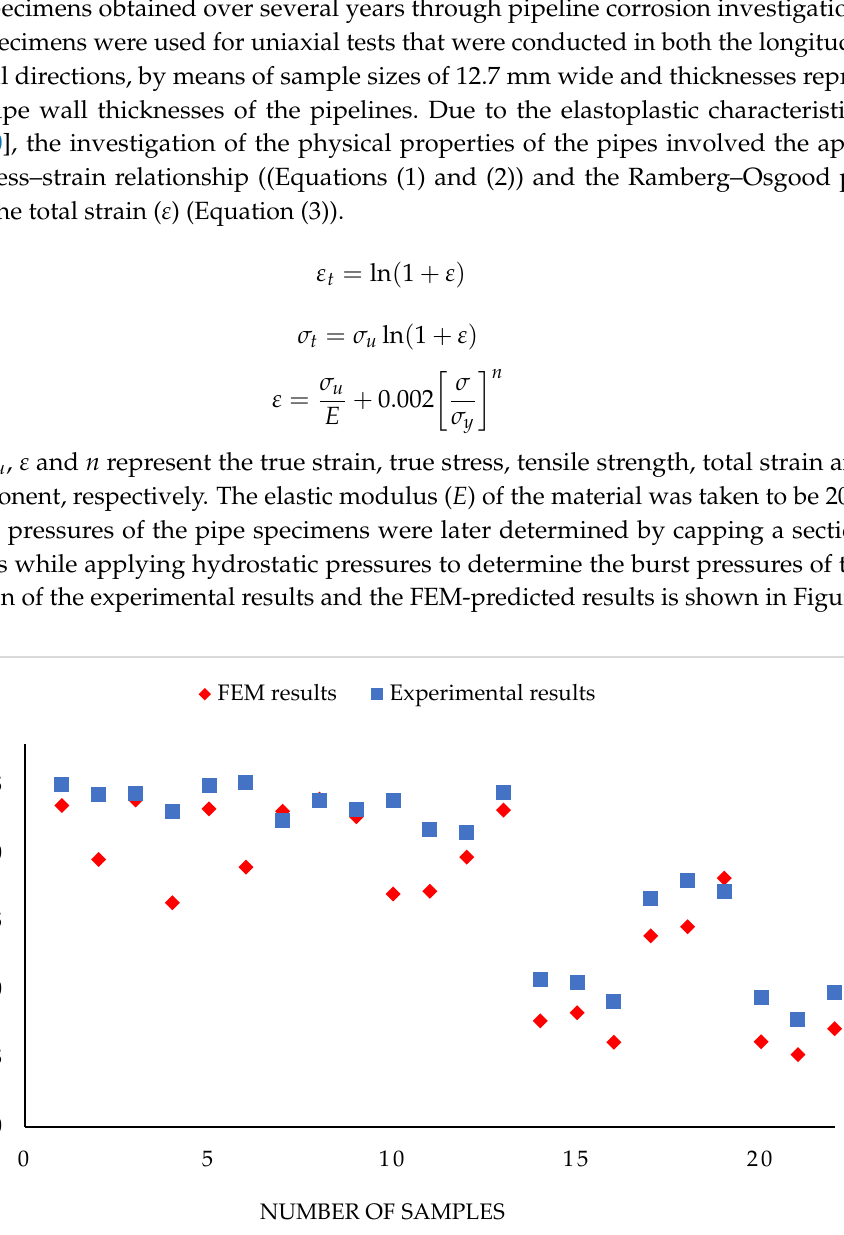
Figure 4. Summary of FEM estimated burst pressures for the pipes—samples 1 to 13 are for X46 (D: 321.56 mm to 324.1 mm), samples 14 to 16 are for X46 (D: 836.6 mm), samples 17 to 19 are for X52 (D: 273.05 mm) and samples 20 to 22 are for X52 (D: 611.35 mm to 612.54 mm).